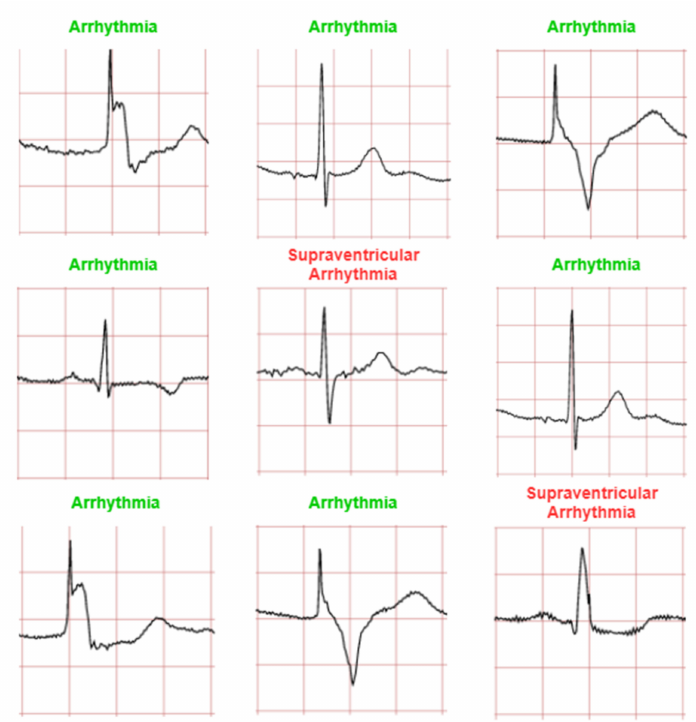
Figure 13. Prediction for ‘arrhythmia’ ECG waveforms. (Note: red and green title indicated incorrect and correct prediction, respectively).